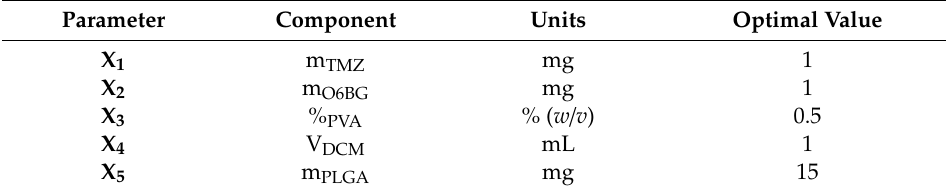
Table 4. Optimal formulation parameters for the PLGA NPs determined by the experimental design.